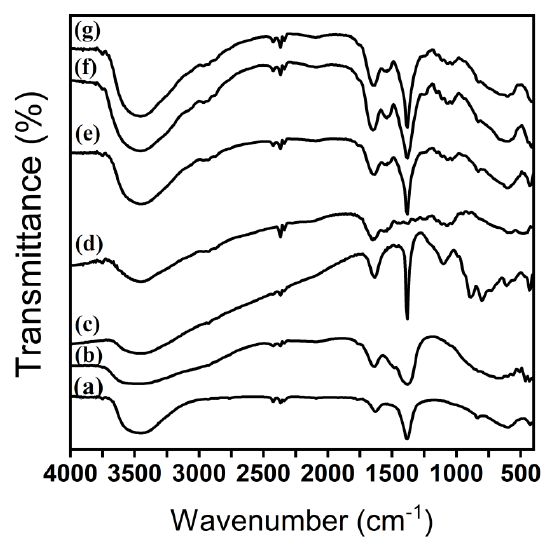
Figure. 2. XRD powder patterns of Zn/Al LDH (a), Mg/Al LDH (b), Ni/Al-LDH (c), Chitosan (d), Zn/Al-CH ©, Mg/Al-CH (f), and Ni/Al-CH (g)